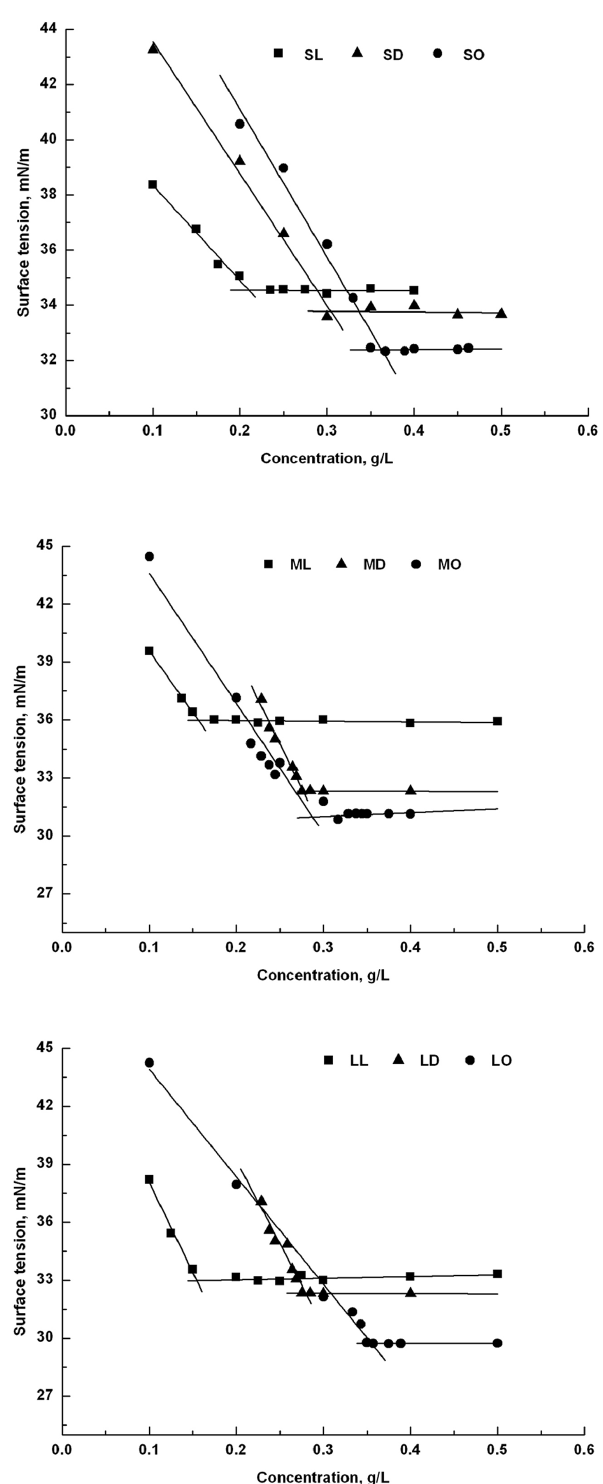
Fig. 1. Surface tension versus concentration plots for sugar monoesters.